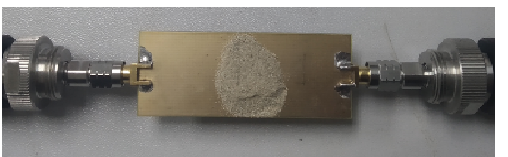
Figure 15. Bituminous sample testing with network analyser.